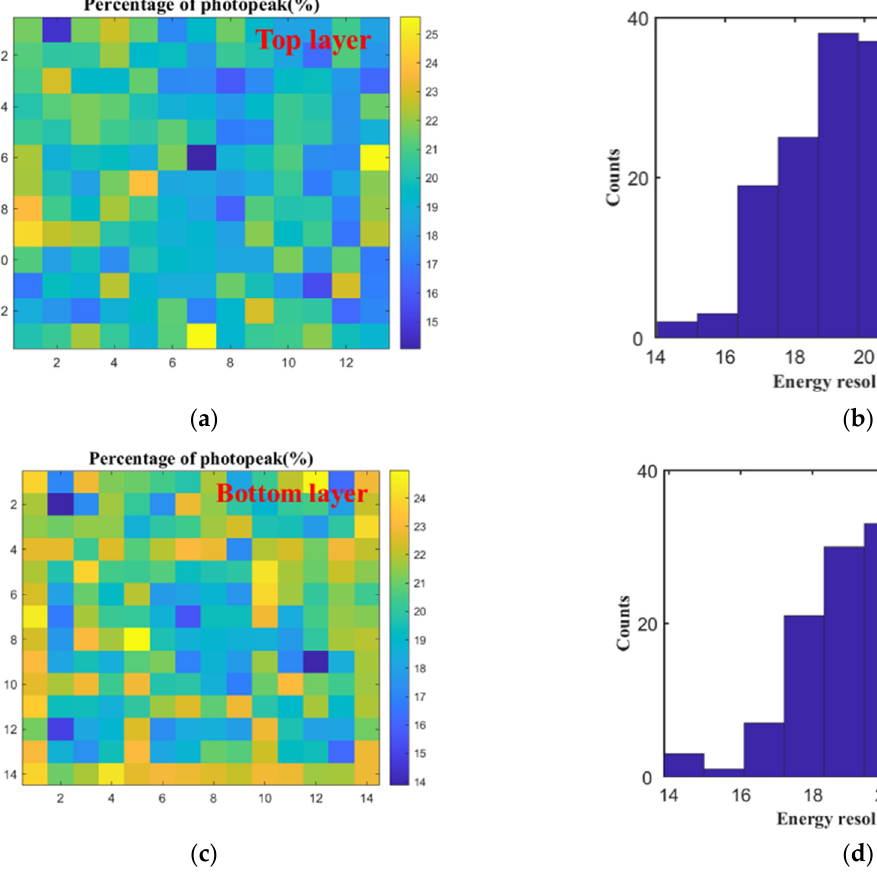
Figure 10. 2D mappings of the energy resolutions of the Toray array: ( a ) the 169 individual crystals of the 13 × 13 crystal array in the top layer and ( c ) the 196 individual crystals of the 14 × 14 crystal array in the bottom layer. The histogram of the energy resolutions of ( b ) 169 individual crystals of the 13 × 13 crystal array in the top layer and ( d ) the 196 individual crystals of the 14 × 14 crystal array in the bottom layer.